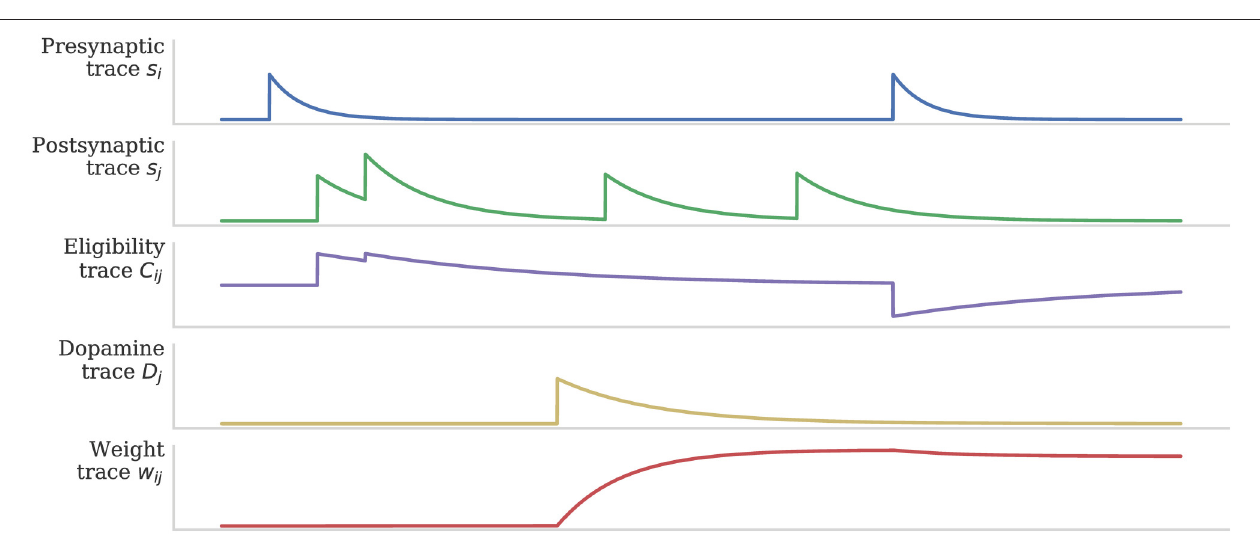
FIGURE 2 | Using eligibility trace C to gate STDP with dopamine D . After Izhikevich (2007).